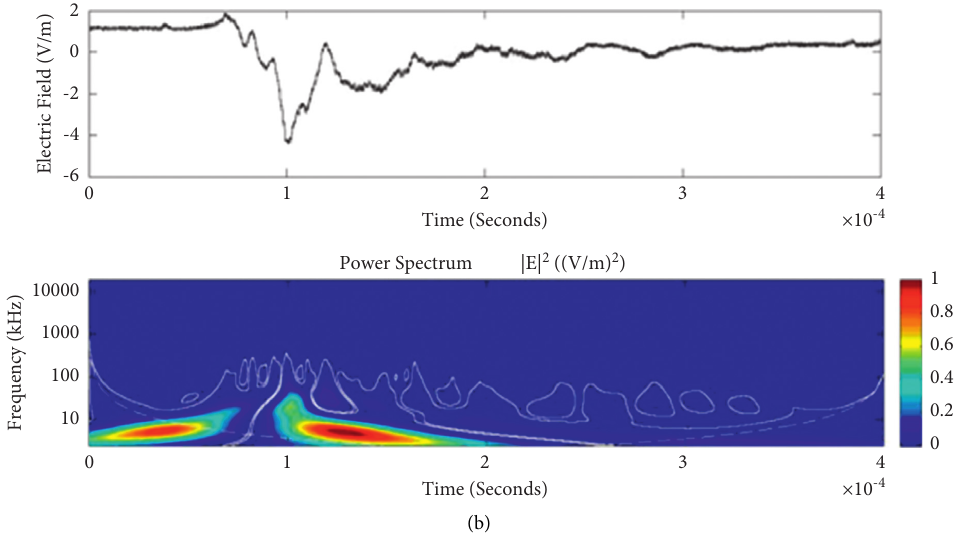
Figure 13: Example of the wavelet power spectrum of the first event (a) and second event (b) of the unusual lightning signal which is recorded as a flash number 20150416-0070 in Kathmandu, Nepal. The window size of the event is 400 μ